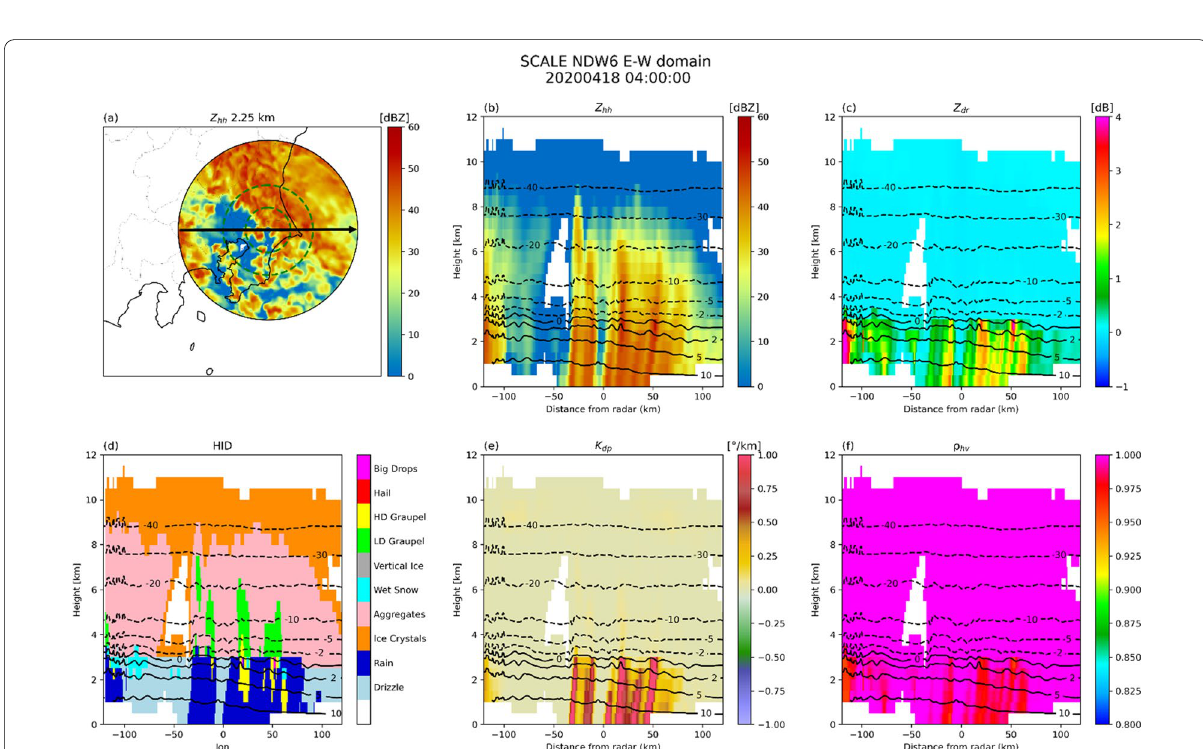
Fig. 22 The same as Fig. 7, but for the SCALE-NDW6